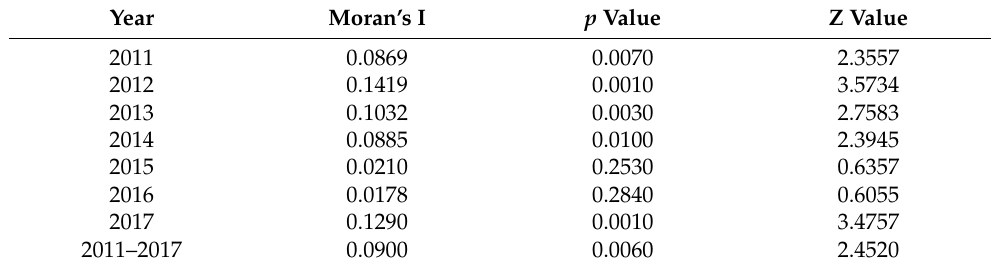
Table 3. Moran’s I statistical values for the EWP of 285 Chinese cities from 2011 to 2017. Year Moran’s I p Value Z Value 2011 0.0869